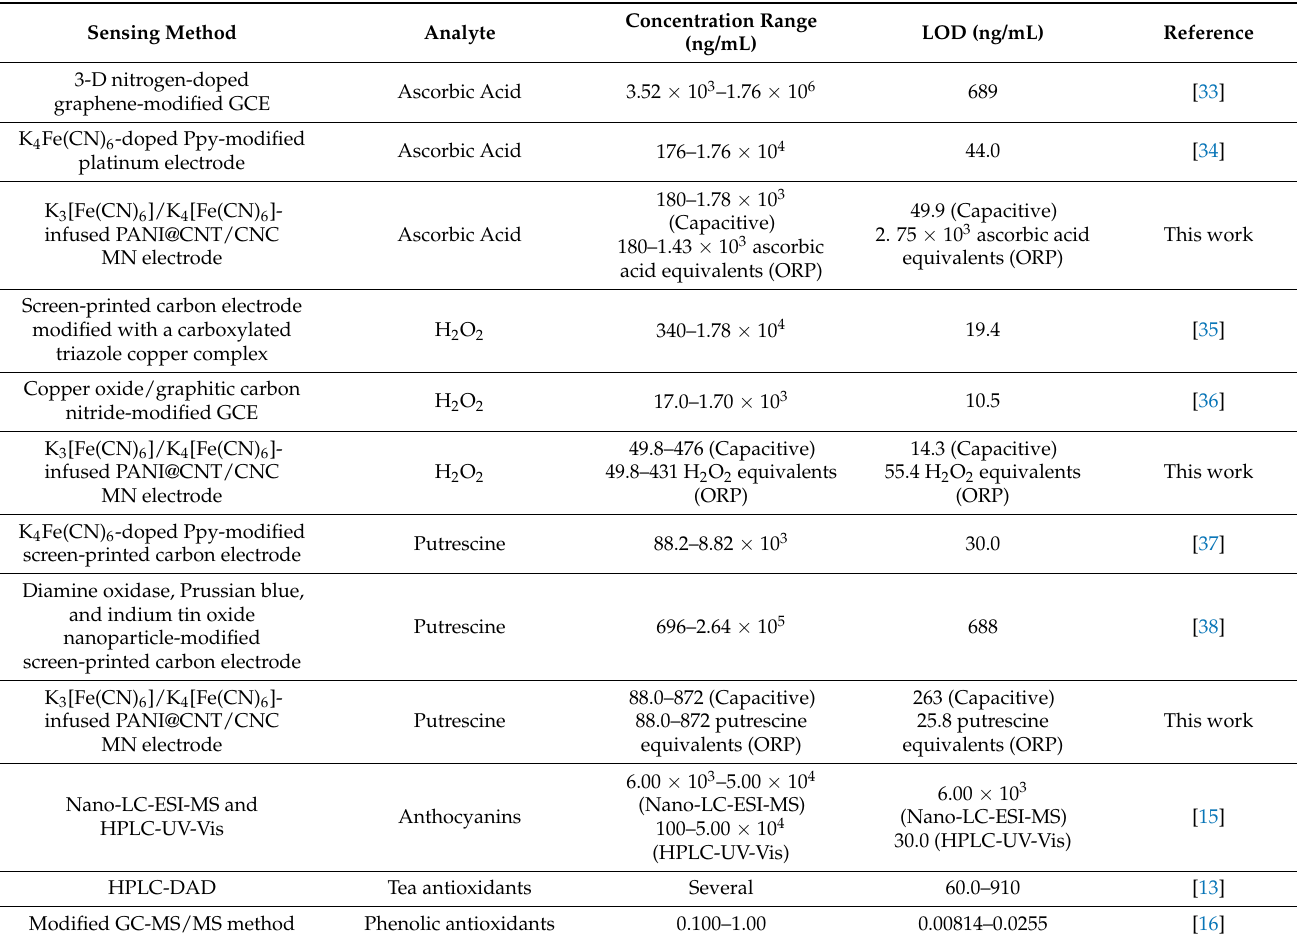
Table 2. Literature comparison of performance metrics of electrochemical and conventional redox analyte determination methods to the reported MN redox